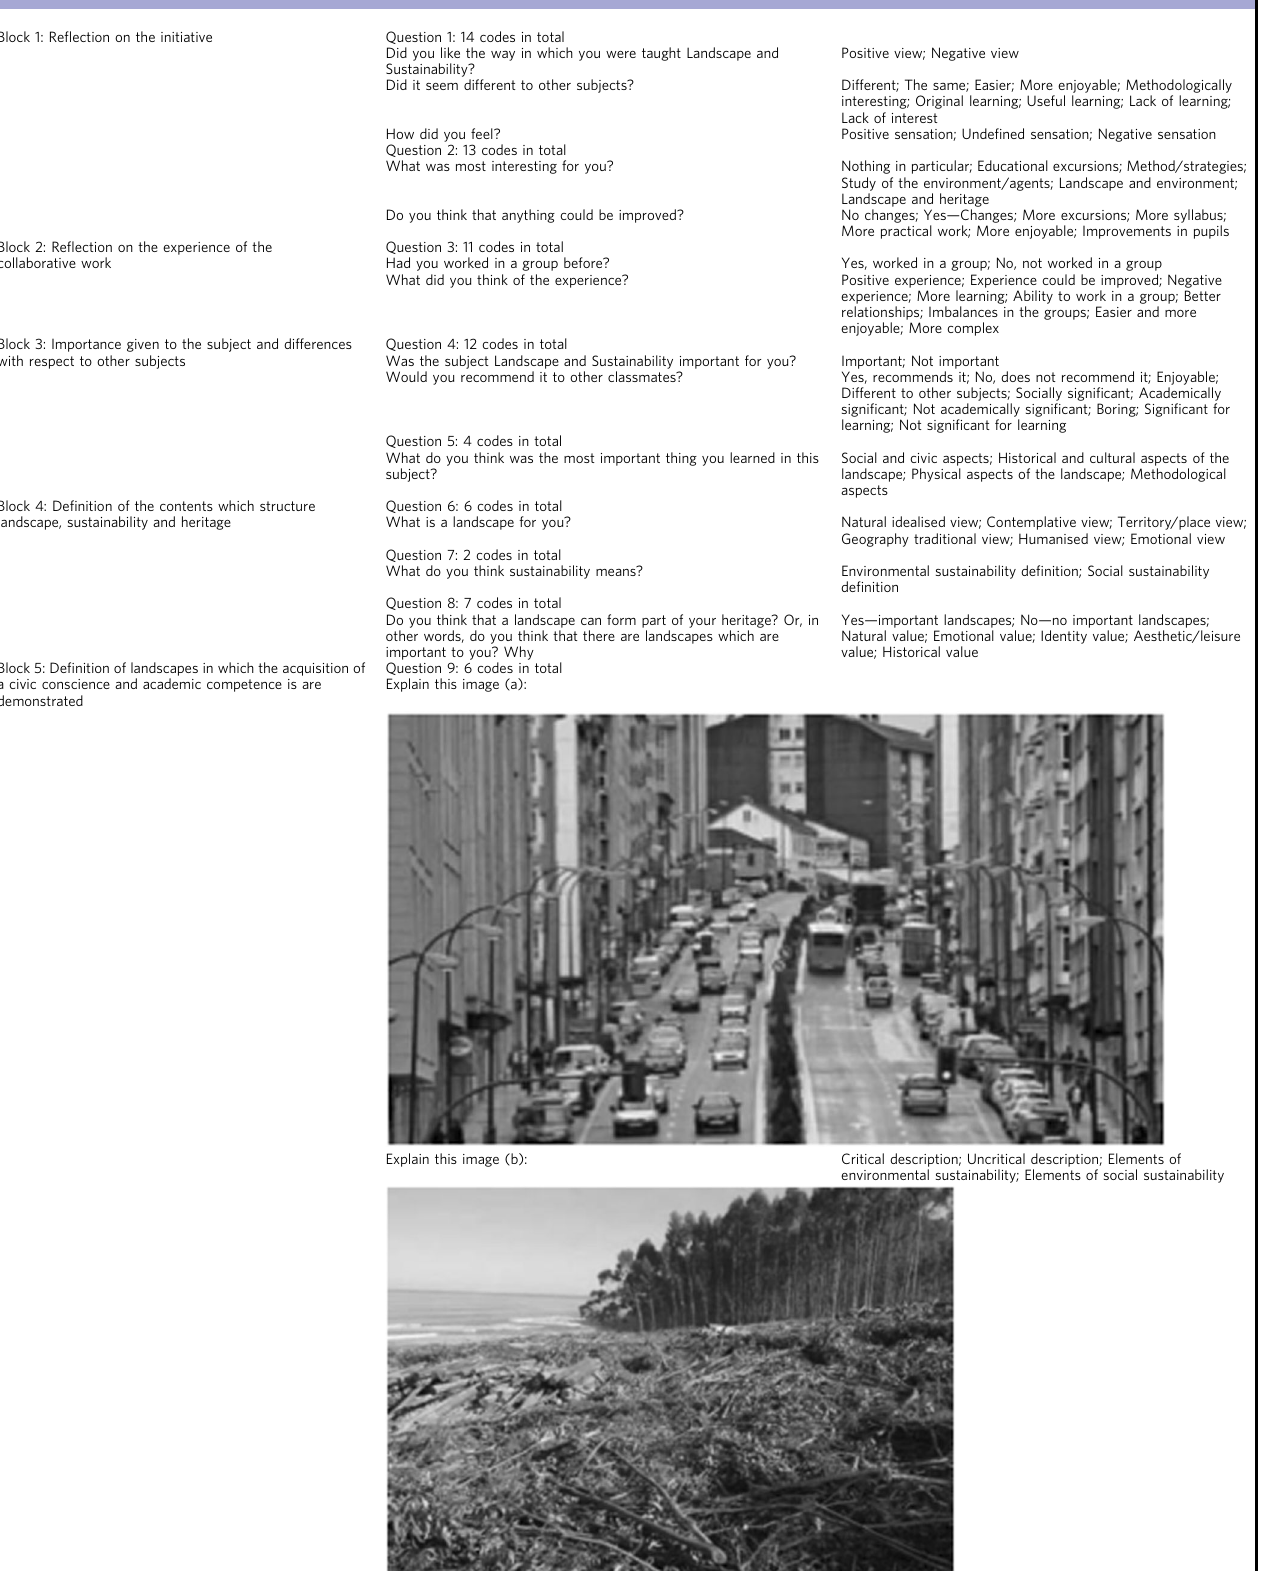
Table 6 List of questions and codes. Block 1: Re fl ection on the